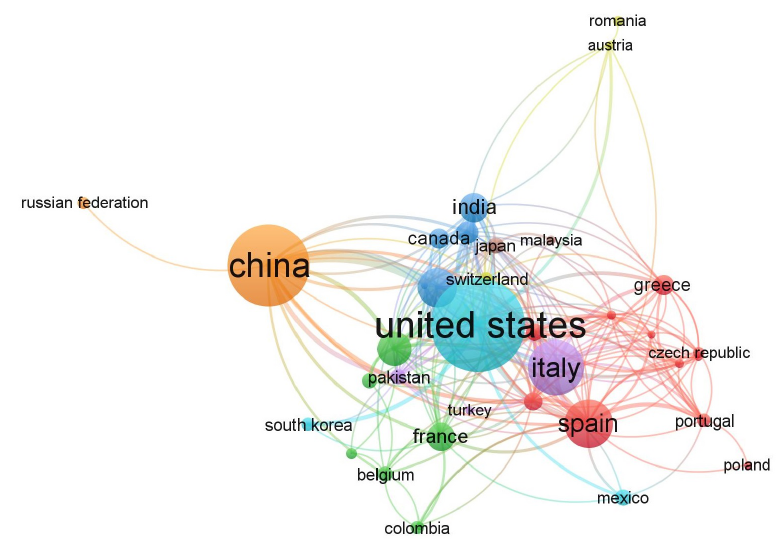
Figure 7. Network showing the co-occurrence of the keywords PA and UAVs in the world (created using VOSviewer https://www.vosviewer.com// accessed on 15 November 2021).